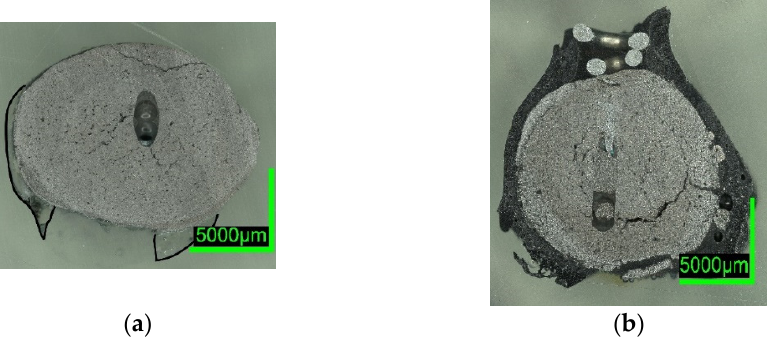
Figure 10. Digital microscope images of ( a ) C800-SAF-1; ( b ) C800-EAF-1, dipped into slag.